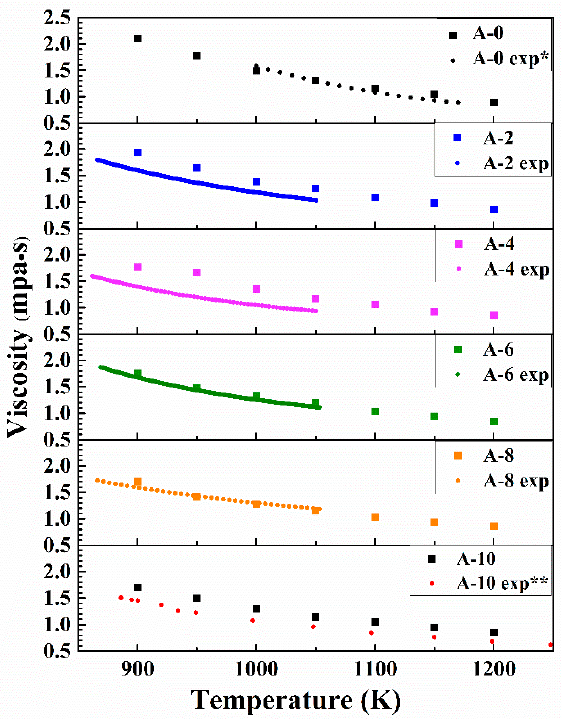
Figure 12. The experimental and simulated values for A-0, A-2, A-4, A-6, A-8 and A-10 at different temperature(Ref * indexed [37]; Ref ** indexed [38]).